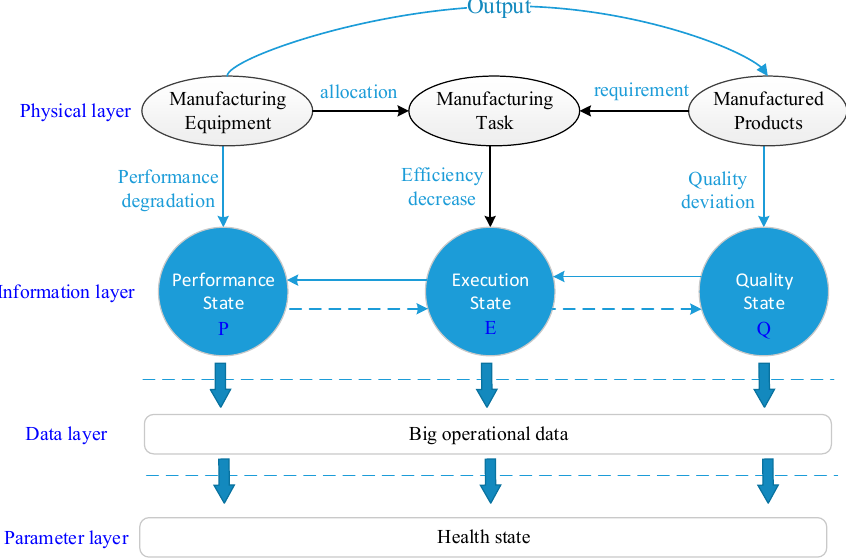
Figure 4. Health state evaluation framework of manufacturing systems.